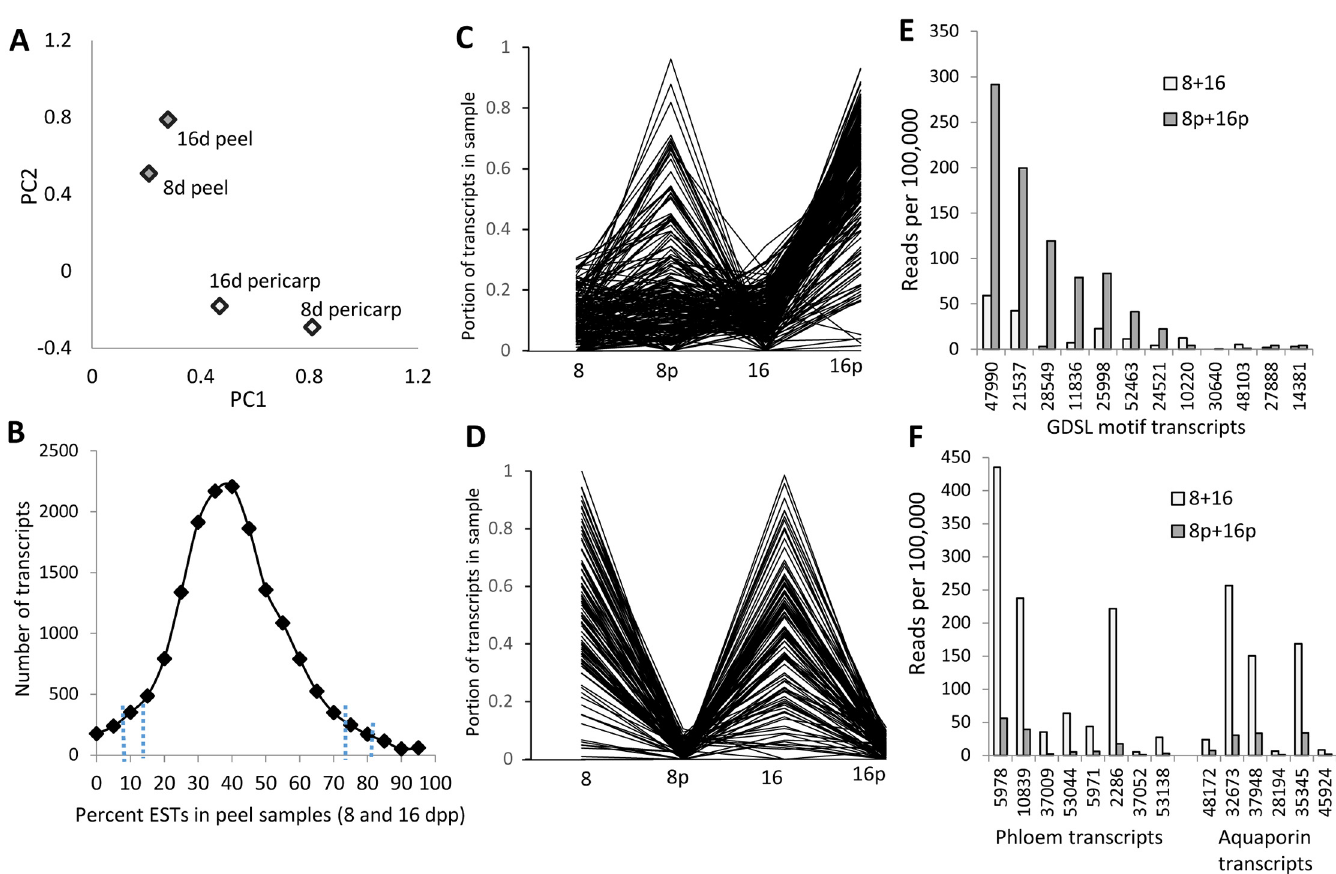
Fig 3. Gene expression in cucumber fruit peel and pericarp samples. (A) Principal component analysis of transcript expression levels for 8 and 16 days post pollination (dpp) peel and pericarp samples for all transcripts with (cid:3) 30 reads. The first two principal components account for 88% of the total variation. (B) Distribution of the portion of gene expression observed in the peel of 8 and 16 dpp fruit for all transcripts with (cid:3) 30 reads. The area to the right or left of the dotted vertical lines demarks those transcripts most strongly or most weakly expressed in the peel (top and bottom 2.5% and 5% respectively). (C, D) Expression patterns relative to fruit age and tissue type of genes preferentially expressed in (C) or excluded from (D) the peel at 8 and/or 16 dpp (8 = 8 dpp pericarp; 8p = 8 dpp peel; 16 = 16 dpp pericarp; 16p = 16 dpp peel). (E, F) Examples of transcripts differentially expressed between the peel (8p, 16p) and pericarp (8, 16) samples. (E) GDSL-motif transcripts. (F) Phloem and aquaporin transcripts. Gene labels refer to cucumber transcript assembly numbers (Sup. File 1).